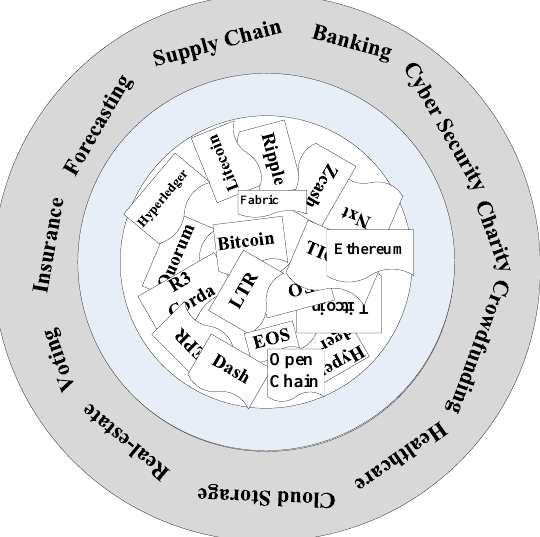
Figure 1. Challenges in current